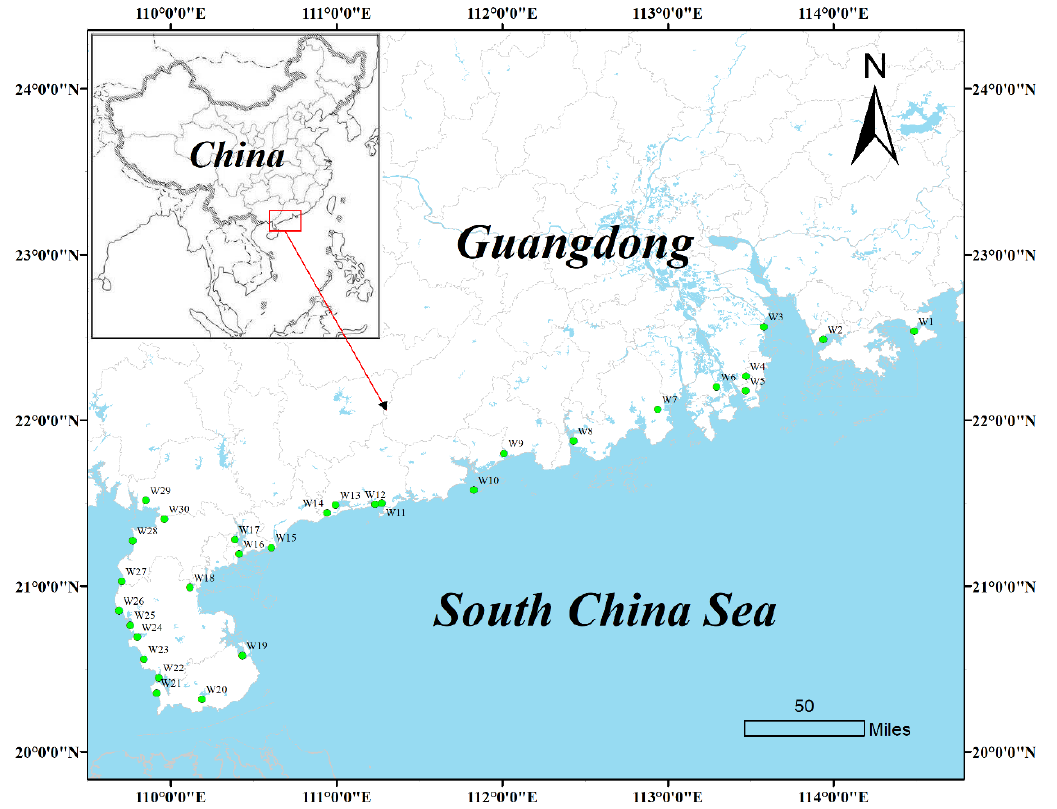
Figure 1. Sampling locations in the coastal areas of central and western Guangdong province.